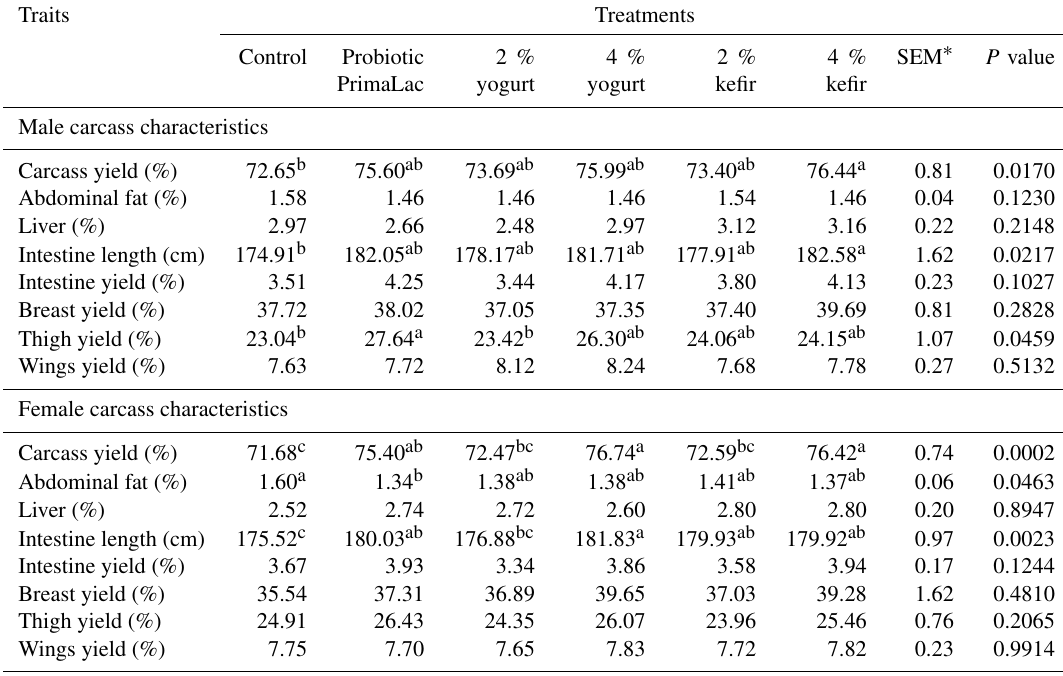
Table 4. The effects of using kefir, yogurt, and probiotic on carcass characteristics (based on live body weight) in male and female broiler chickens at